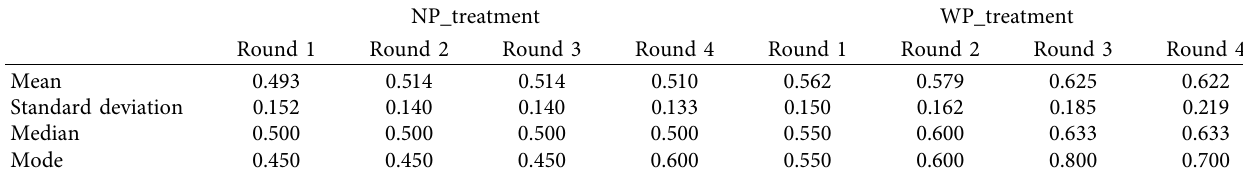
Table 1: Corporate resource investment rates in different rounds.